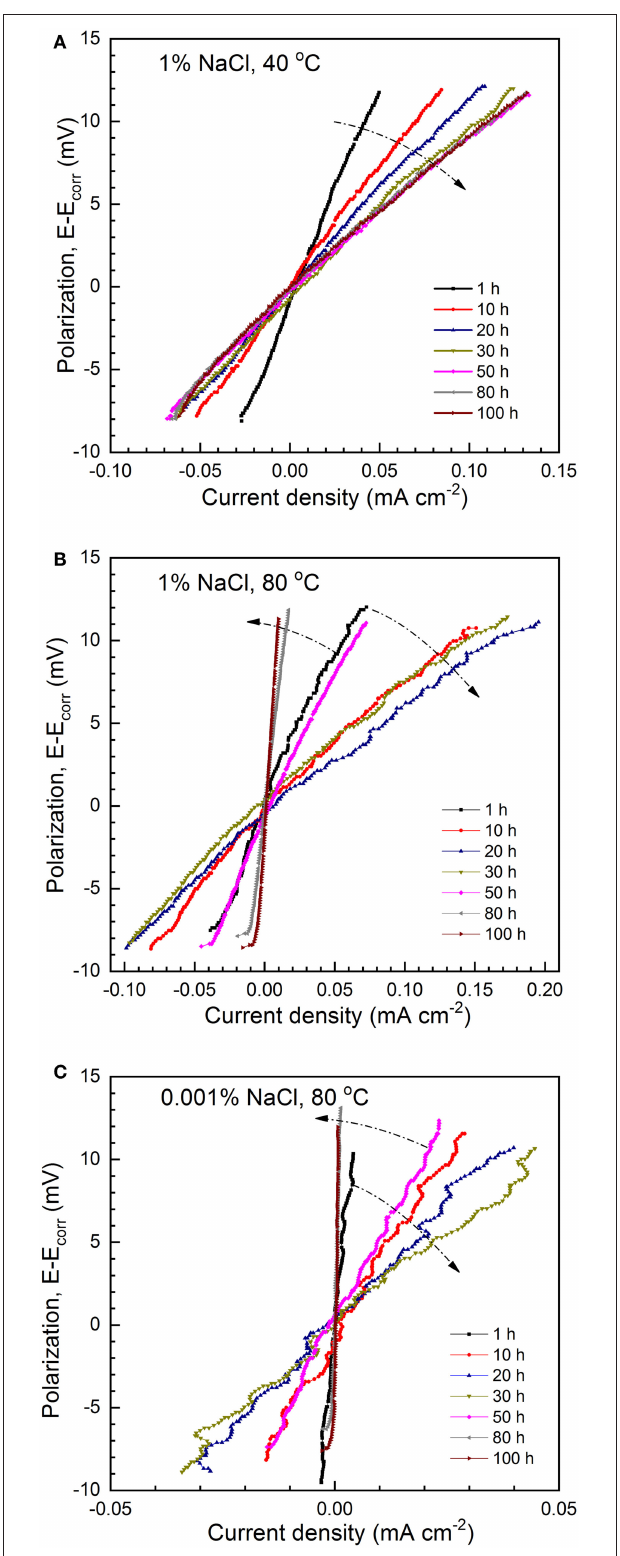
FIGURE 4 | The evolution of LPR curves of C1018 in (A) 1% NaCl, 40 ◦ C, (B) 1% NaCl, 80 ◦ C, and (C) 0.001% NaCl, 80 ◦ C with CO 2